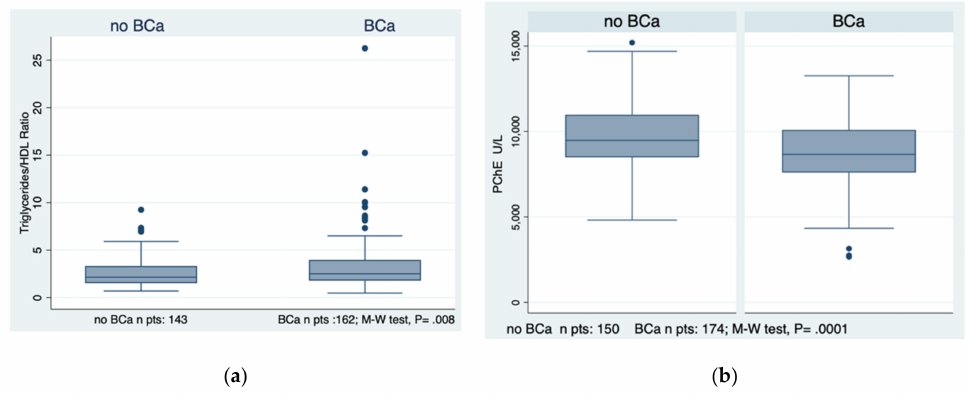
Figure 2. The behaviour of the TG/HDL ratio and pseudocholinesterase levels in the two major groups, i.e., bladder cancer and no bladder cancer is evidenced in subfigures ( a , b ). BCa, bladder cancer; no BCa, no bladder cancer; PChE, pseudocholinesterase; M-W test, Mann–Whitney test.